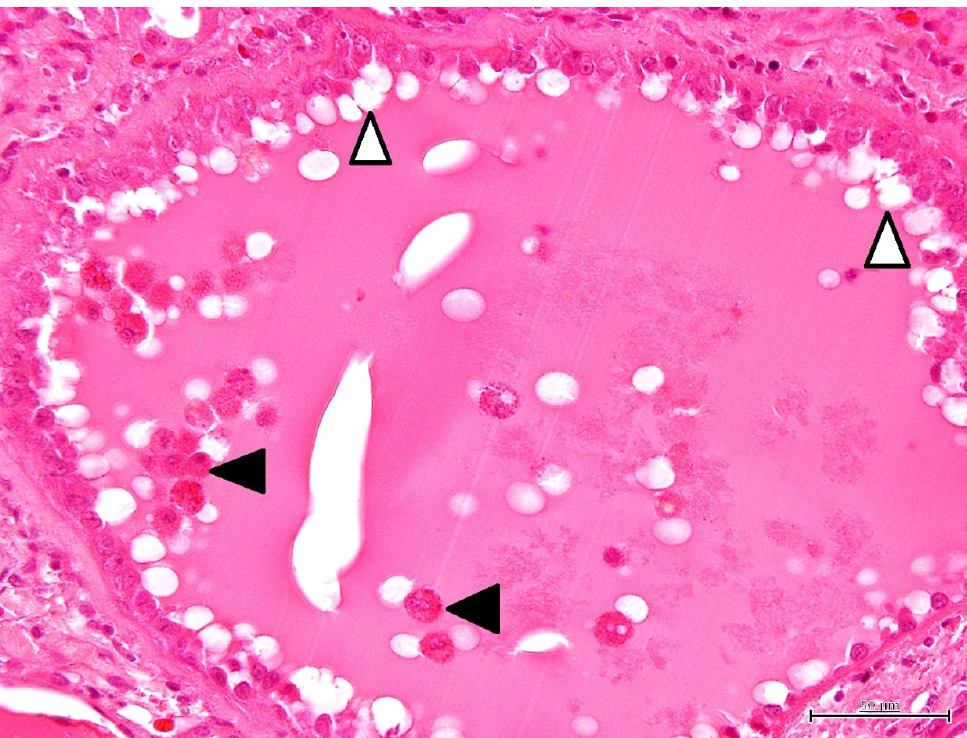
Figure 3. Microscopic finding of polycystic kidney. The cyst contains a large number of macrophages (solid arrowhead). Vacuoles (open arrowhead) is observed around the low cuboidal epithelium. HE stain. ×400, Bar = 50 μ m.